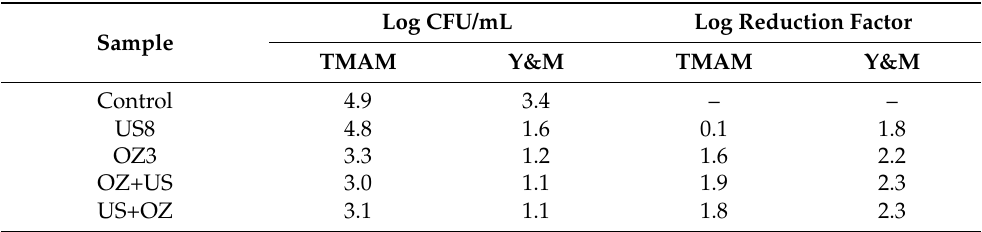
Table 2. Logarithmic reduction factor (LRF) after single and combined non-thermal processing of cashew apple